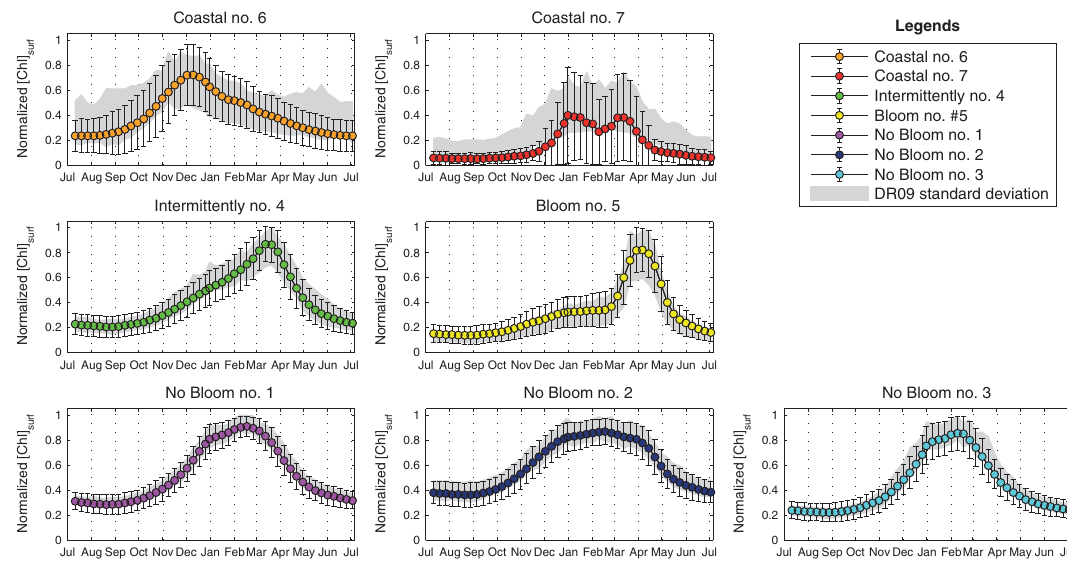
Figure 7. Mean time series of the DR09 trophic regimes (in color) and their standard deviations (vertical bars) obtained from our analysis. The standard deviations from the DR09 methodology (in shade area) are obtained by applying the DR09 methodology (i.e., a K-means) on a weekly climatology done with the 16-year database.